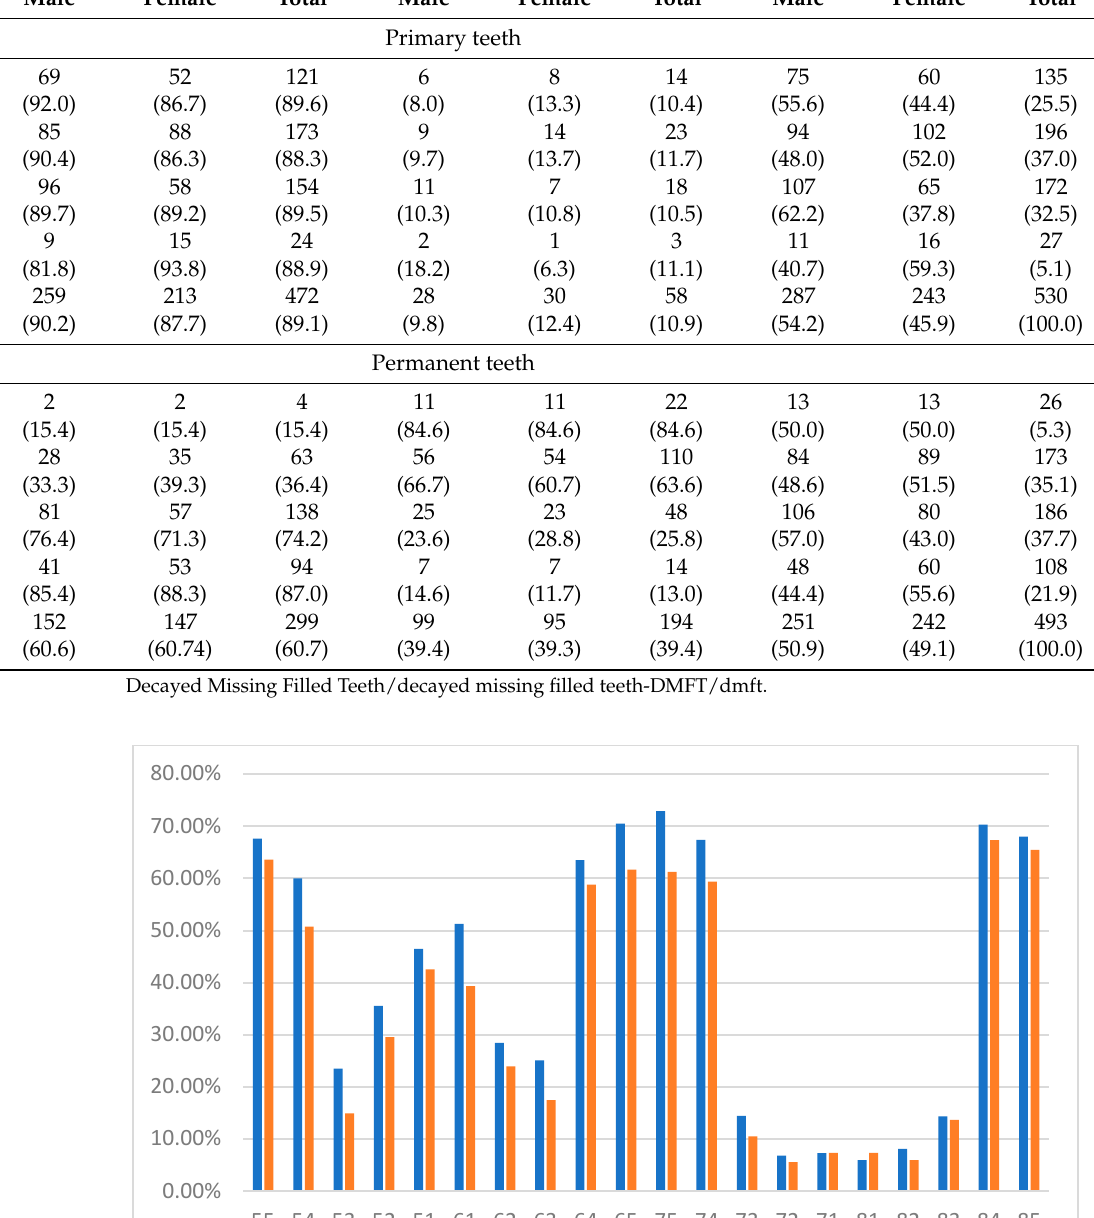
Figure 2. Distribution of DMFT according to the tooth type . 4. Discussion The results of our research show a very high prevalence of caries in primary and permanent dentition in the sample that we examined. Overall, the prevalence of caries in primary teeth was 89.1%, whereas in permanent dentition, it was 60.7%. Individual caries indices were also high. The mean DMFT index at the age of ≤ 5 years was 6.6, whereas the SiC index was 12.2. In the 12–15-year-old age group, the mean DMFT was 6.8, and the SiC was 13.4. The restoration rate was very low in the study groups and, particularly in the age of ≤ 5 years, where the mean number of treated-missing and filled mf/MF teeth was 0.7, and in the 12–15-year-old age group, where it was 2.4. In 1981 the World Health Organization—WHO declared that the global goal for oral health by the year 2000 regarding DMFT index for 12-year-olds should not exceed 3 [20]. Subsequently, the WHO set forth new recommendations entitled Oral Health Guidance for 2020 for countries to use when setting their goals and objectives for improving the oral health of their citizens [21]. In accordance with such proposals, Spain defined its basic goals for oral health for the period from 2015–2020 with a goal of achieving a mean DMFT